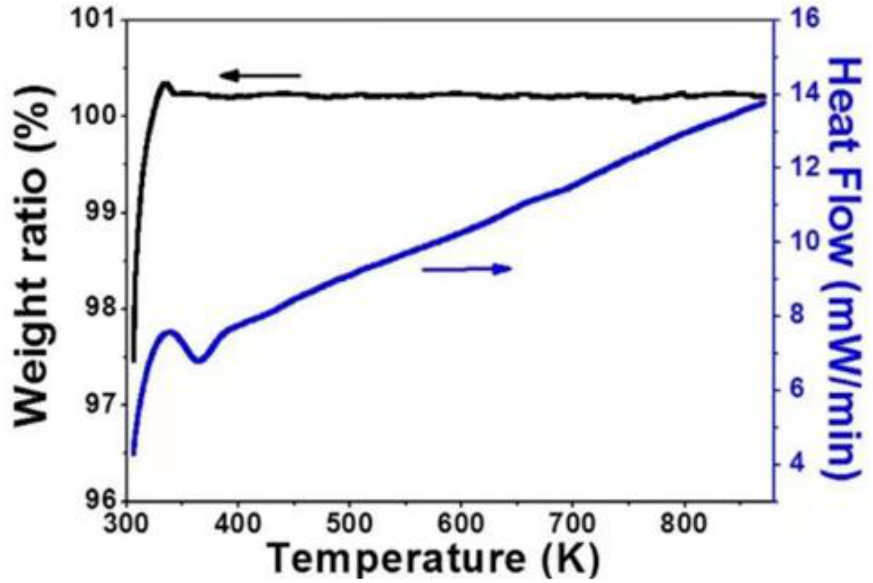
Figure 14. Thermogravimetric differential scanning calorimetry curve. Adapted with permission [78], Copyright 2015, Scientific Reports.